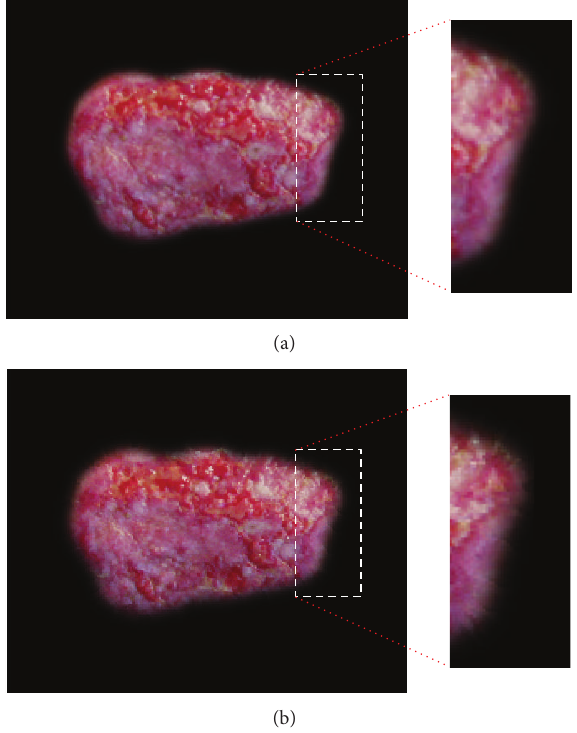
Figure 4: Shapes of contracted wounds using (a) the image scaling method and (b) the weighted warping method.